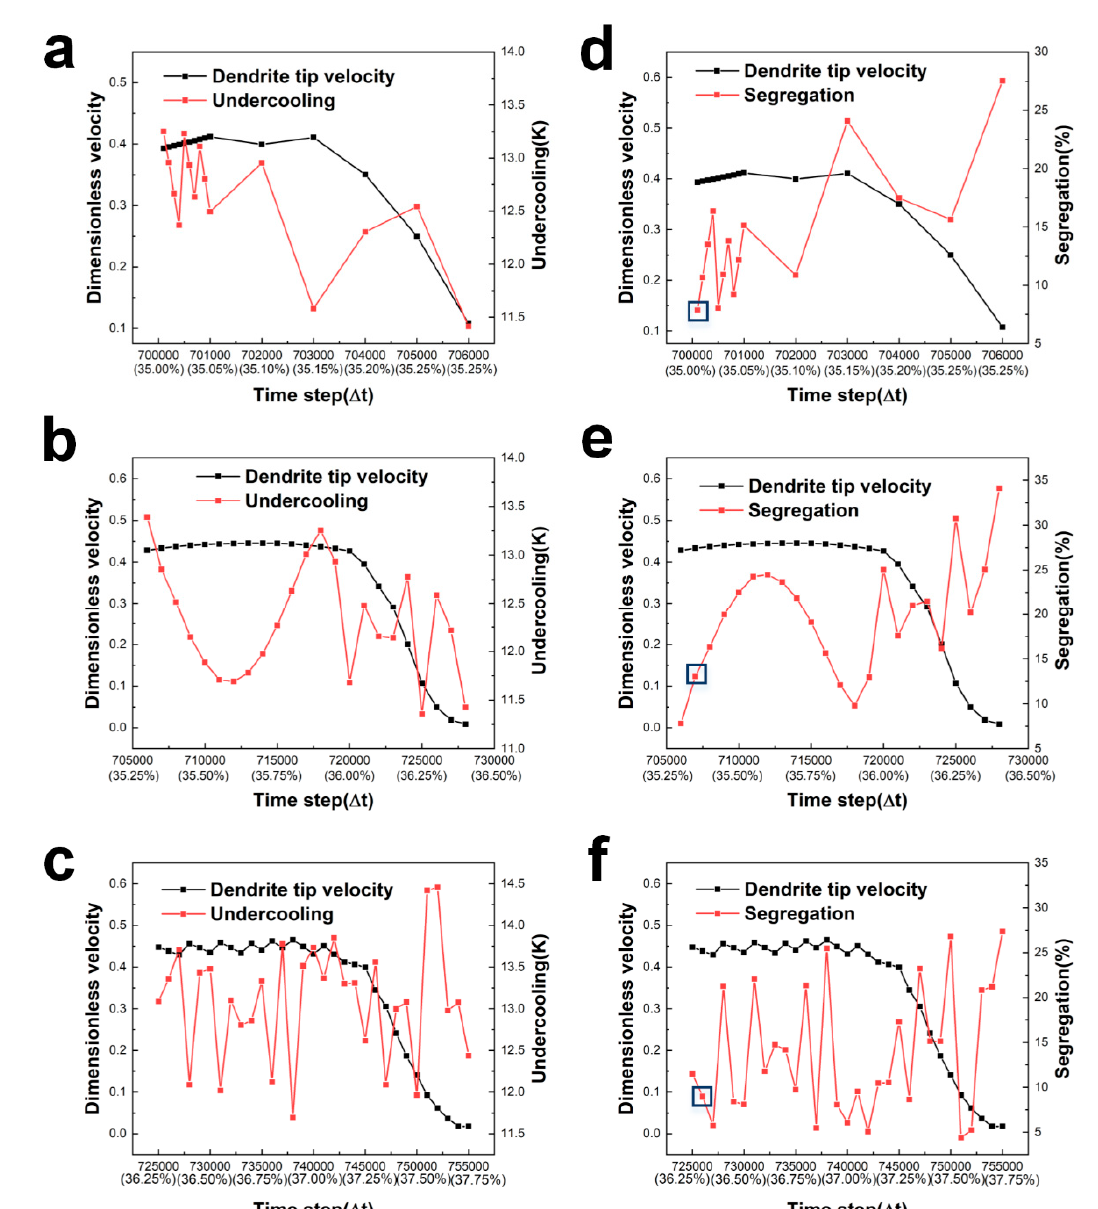
Figure 14. The velocity and undercooling variations of columnar dendrite tip with time for U n = 11 K and X f = 200 ∆ x : ( a ) D n = 200 ∆ x ; ( b ) D n = 400 ∆ x ; ( c ) D n = 500 ∆ x . The velocity and solute segregation variations of columnar dendrite tip with time for U n = 11 K and X f = 200 ∆ x : ( d ) D n = 200 ∆ x ; ( e ) D n = 400 ∆ x ; ( f ) D n = 500 ∆ x .